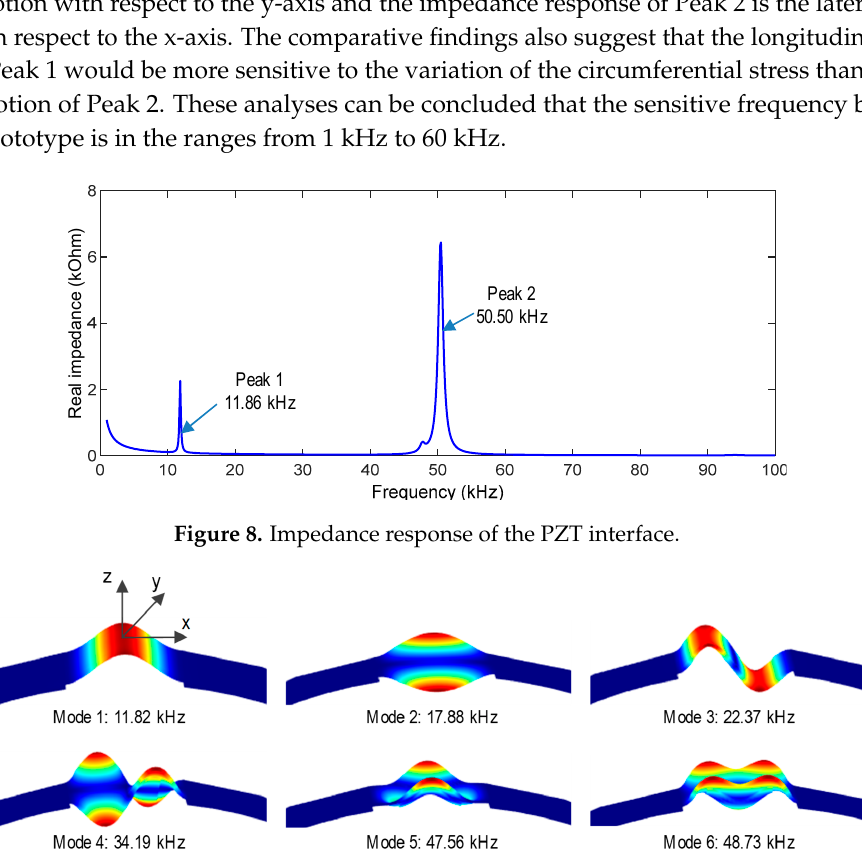
Figure 9. Eigen-modes of hoop-type PZT interface.